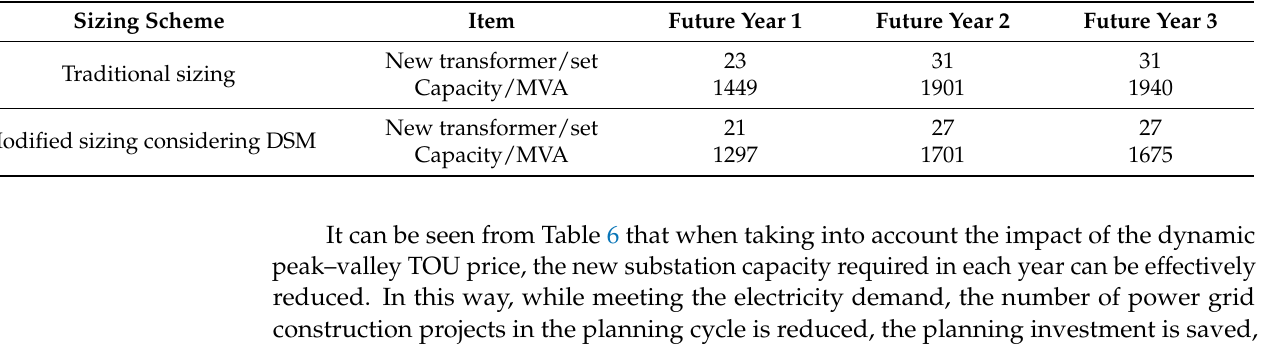
Table 6. 110 kV substation planning and its corresponding modified results considering DSM (MW).